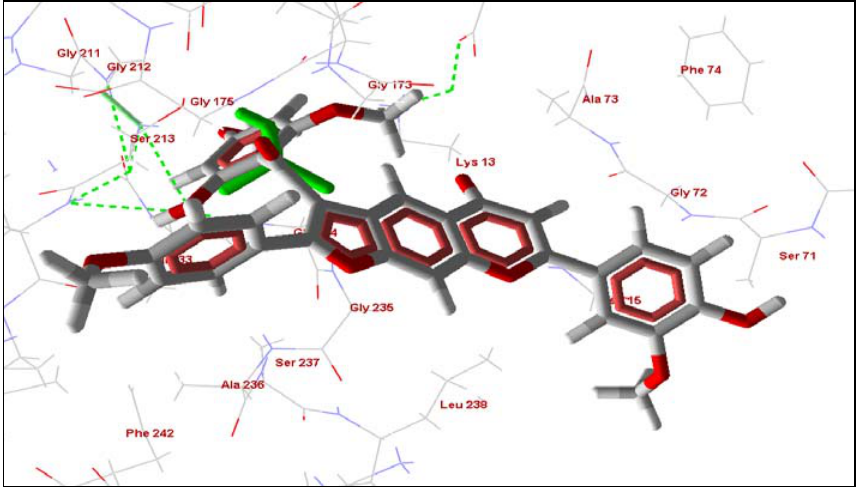
Figure 8. Cissampeloflavone (red and white) and HPO42- (green) at the phosphate binding site of TIM. Hydrogen bonding interactions are shown as green dashed lines.